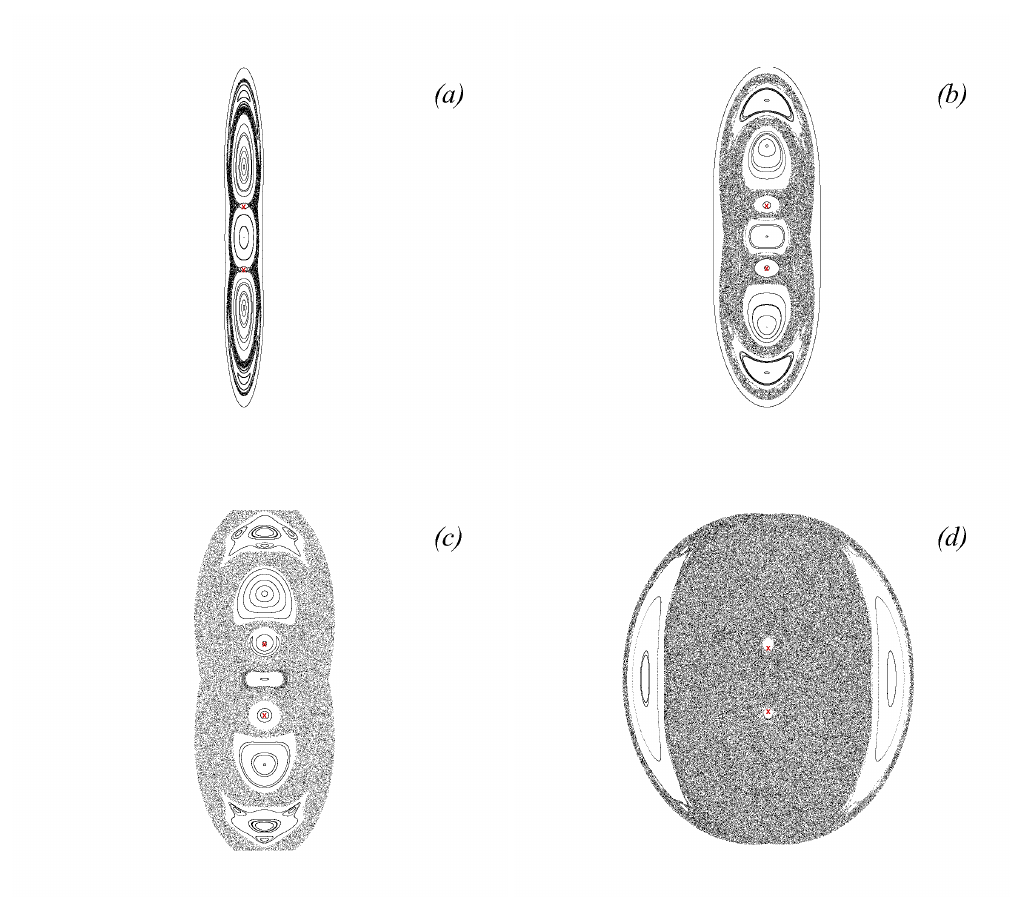
Figure 24. Poincaré maps illustrating the increase of the chaotic advection zone in the upper layer for µ 1 = µ 2 = 0.3 and Ω 0 = − 0.02 as the absolute value of the strain intensity is being decreased, S 0 : ( a ) − 0.019; ( b ) − 0.014; ( c ) − 0.011; and ( d ) −